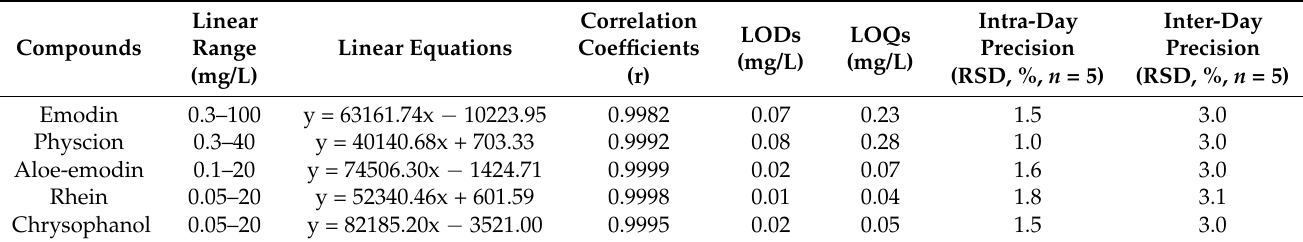
Table 3. The linear equations, correlation coefficients, precision, limits of detection (LODs, 3SD/ m ), and limits of quantification (LOQs, 10 SD/ m ) for emodin, physcion, aloe-emodin, rhein, and chryso- phanol.